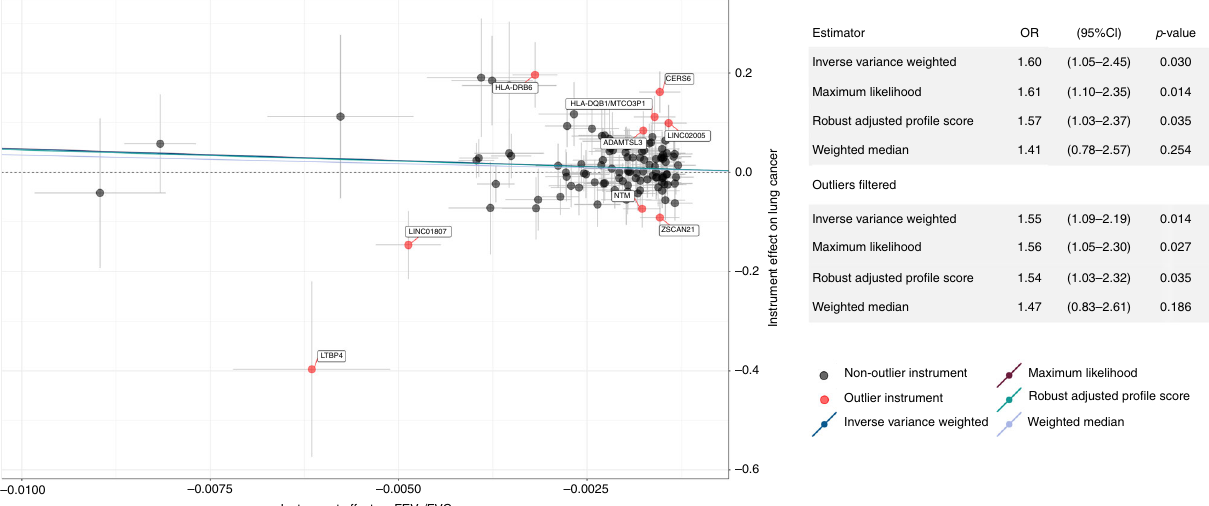
Fig. 5 Scatterplot depicting the Mendelian randomization (MR) results for FEV 1 /FVC in never smokers and lung cancer in never smokers (2355 cases, 7504 controls). The scatterplot illustrates the effects of individual instruments on FEV 1 /FVC and lung cancer risk, highlighting potentially invalid outlier instruments that were fi ltered. Individual instrument effects in the scatterplot correspond to a 1-unit decrease in FEV 1 /FVC, but the summary odds ratios (ORs) for lung cancer have been rescaled to correspond to a 10% decrease in FEV 1 /FVC. Summary log(ORs) based on different MR estimators correspond to the slope of the lines in